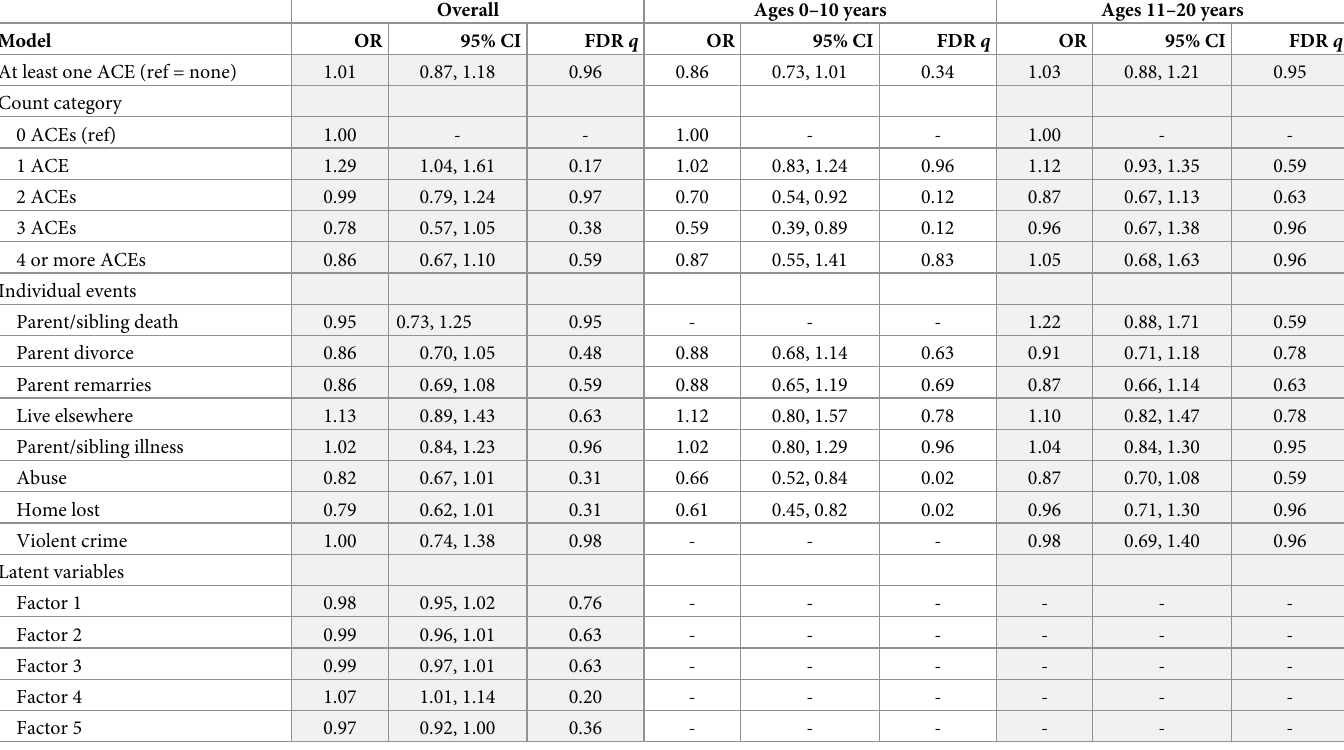
Table 3. Results from multivariable logistic regression models of the effect of adverse childhood experiences (ACEs) during two age periods on odds of multiple sclerosis.